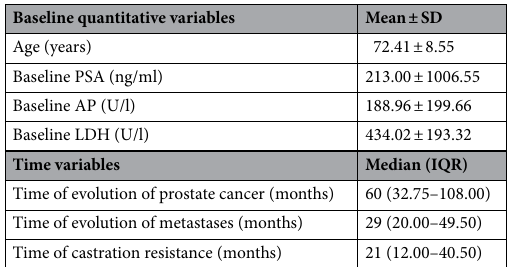
Table 1. Patient and tumor characteristics. SD standard deviation, AP alkaline phosphatase, LDH lactate dehydrogenase, PSA prostate specific antigen, IQR interquartile